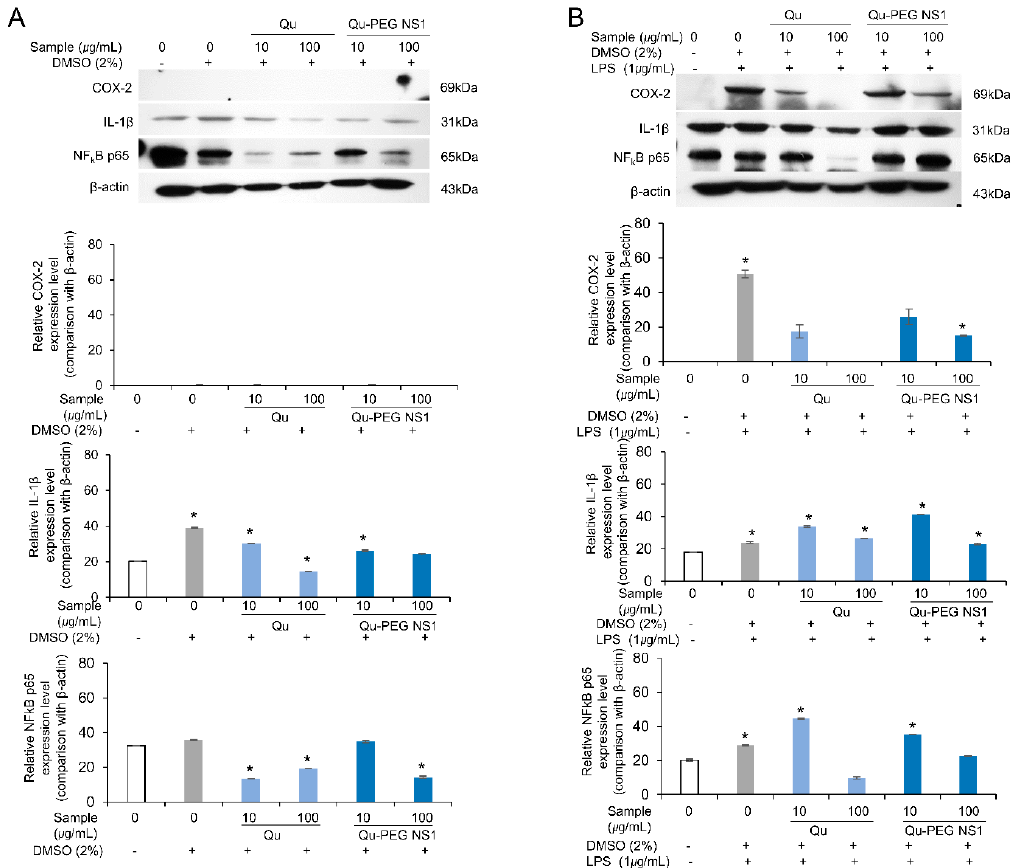
Figure 10. Effects of Qu and Qu-PEG NS on RAW 264.7 cells ( A ) in the absence of LPS and ( B ) in the presence of LPS on the expression of COX-2, IL-1 β , and TNF- α -activated NF- κ B (p65) as biomarkers of inflammation. The β -actin was employed as base level of protein expression. * p < 0.05 indicates a significant difference.